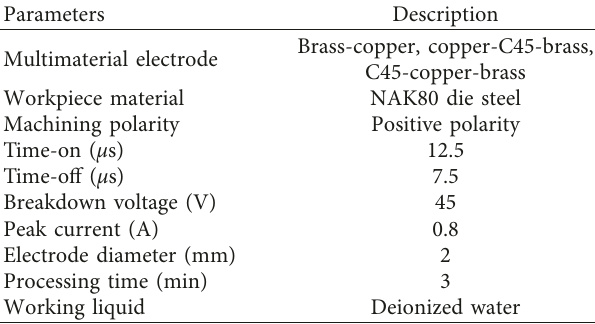
Table 4: Multimaterial electrode materials and processing